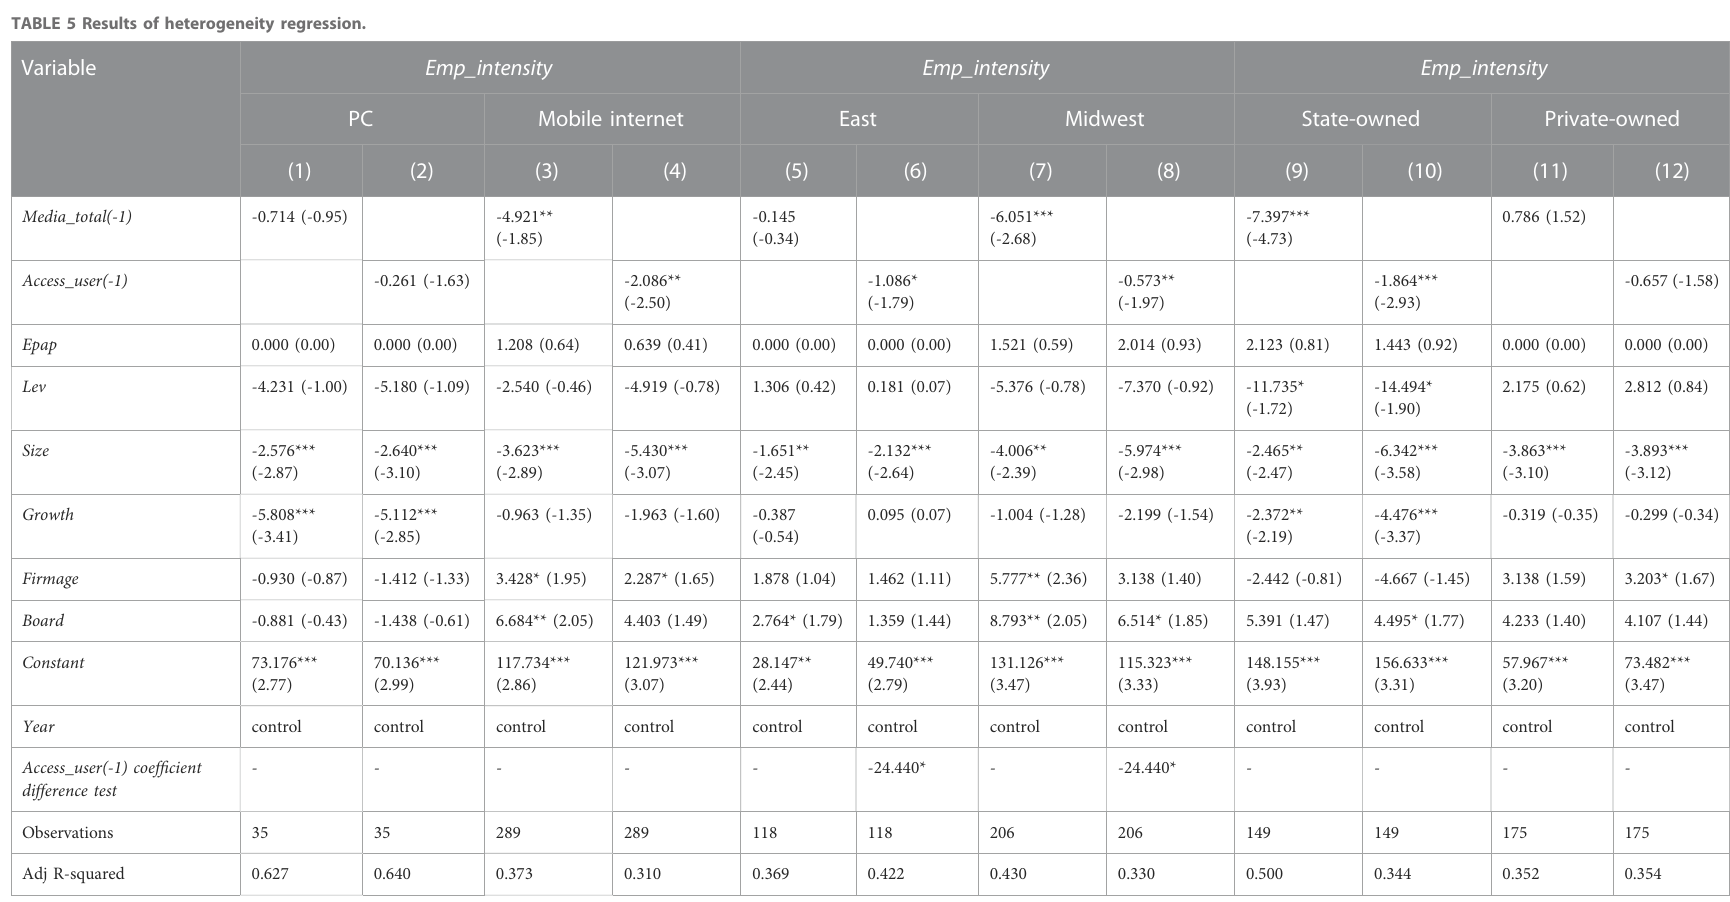
TABLE 5 Results of heterogeneity